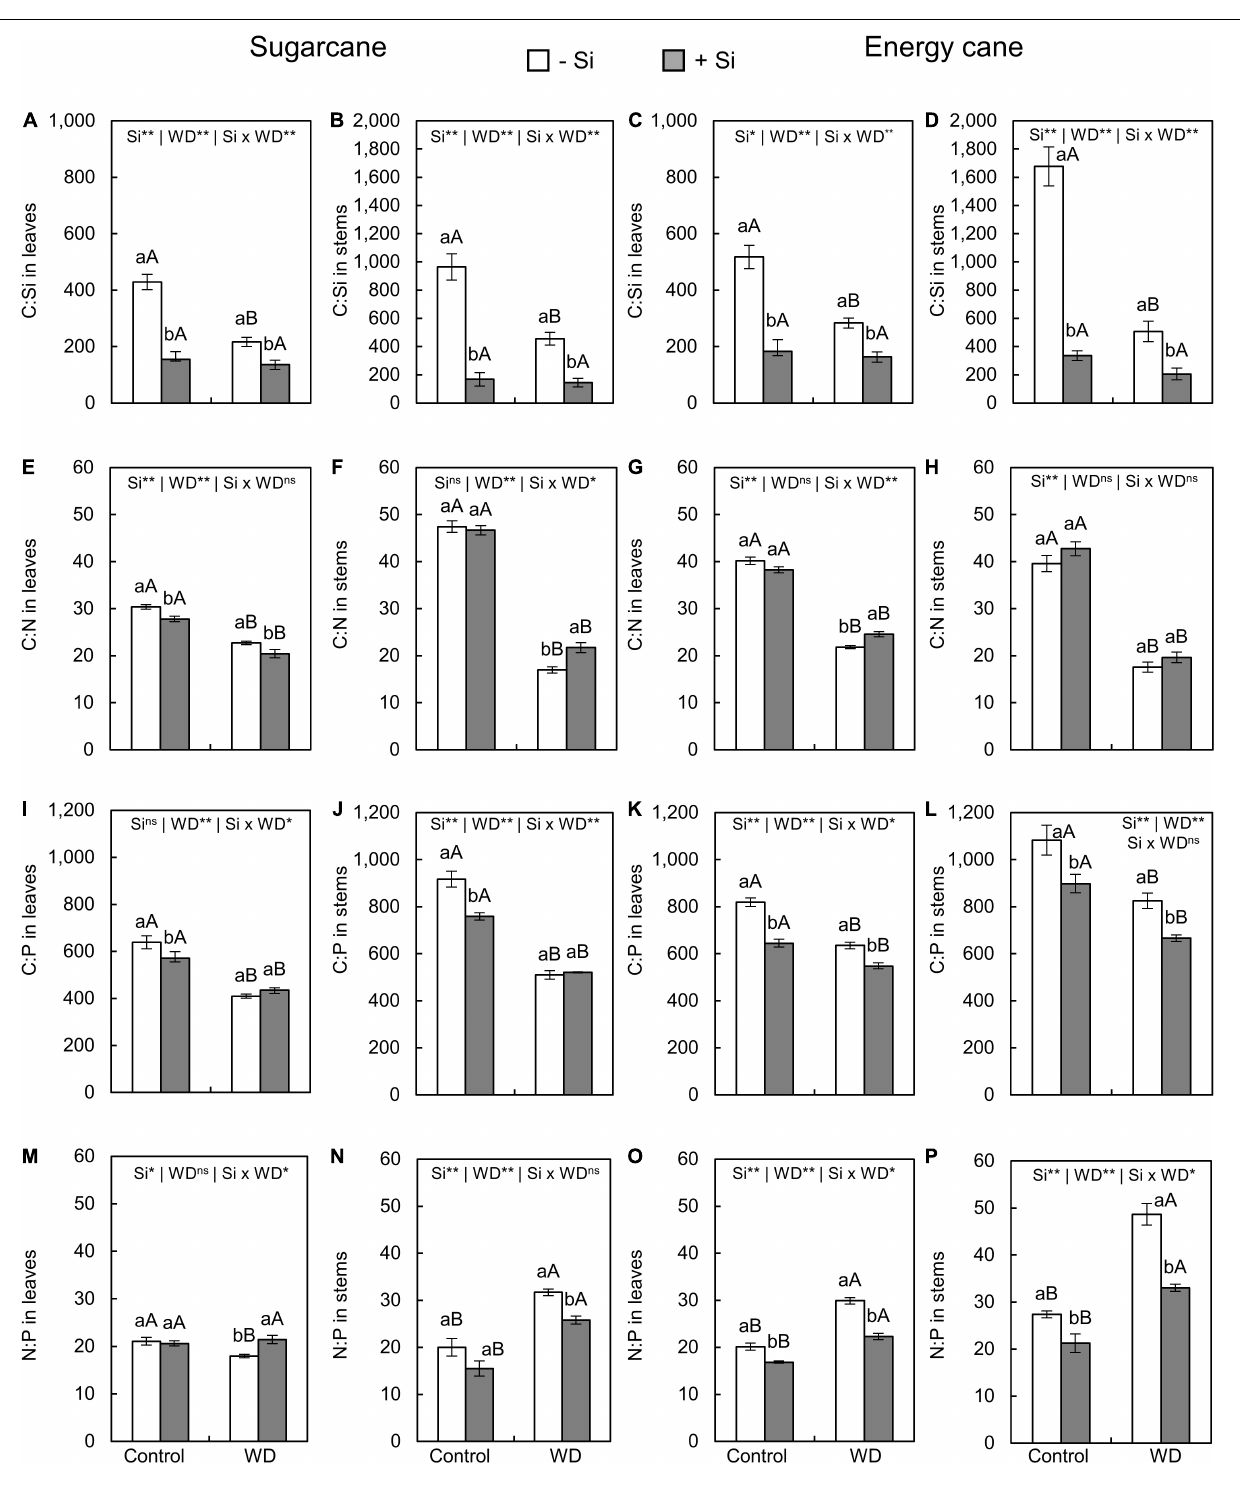
Frontiers in Plant Science |